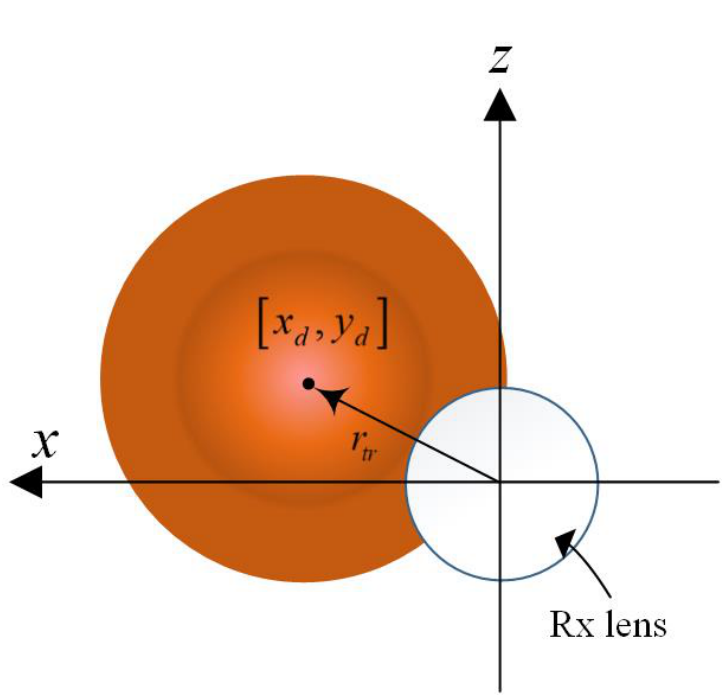
Figure 3. Modeling the received beam at the FSO Rx station in the presence of fluctuations due to UAV